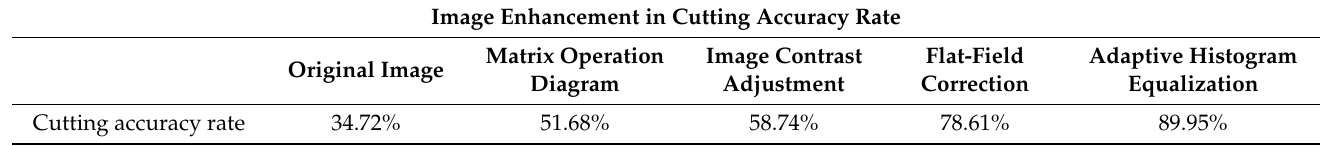
Table 2. Accuracy rates for image enhancement.